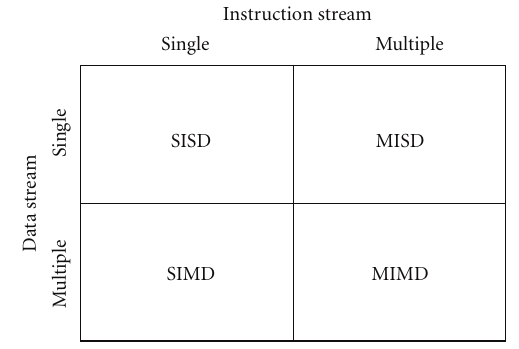
Figure 7: Flynn’s taxonomy